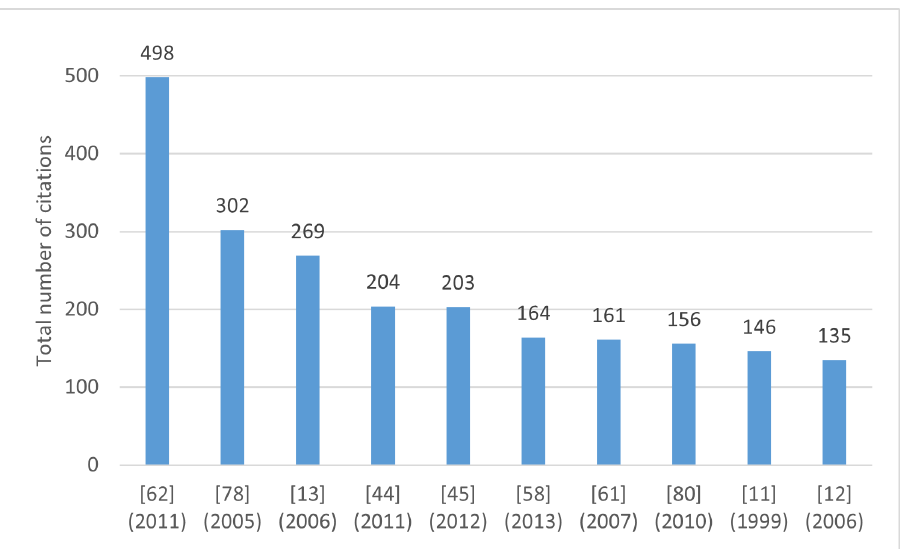
Figure 3. Top ten articles about MADM methods in AM based on total number of citations.